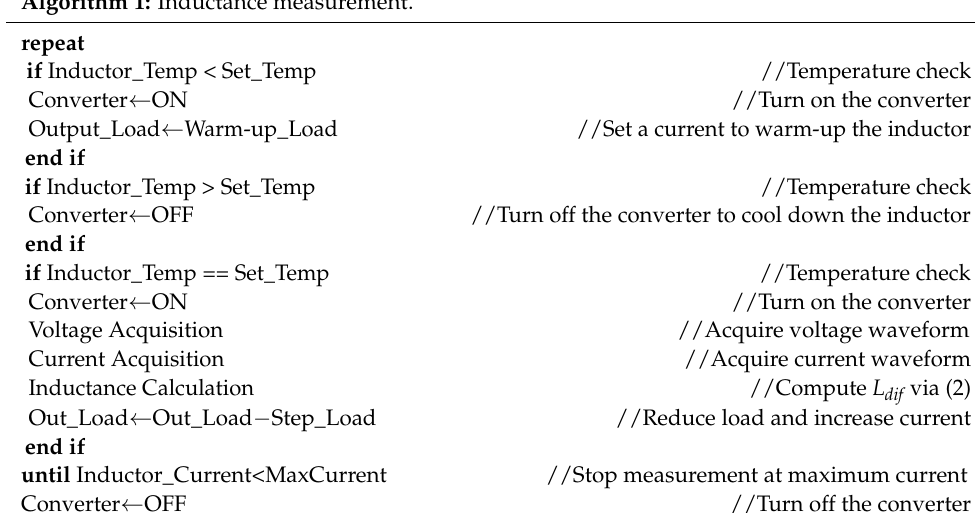
Algorithm 1: Inductance